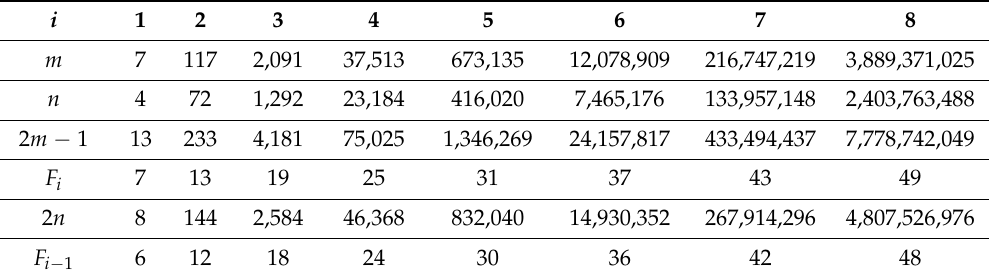
Table 2. Comparison of the proposed method vs. Fibonacci sequence